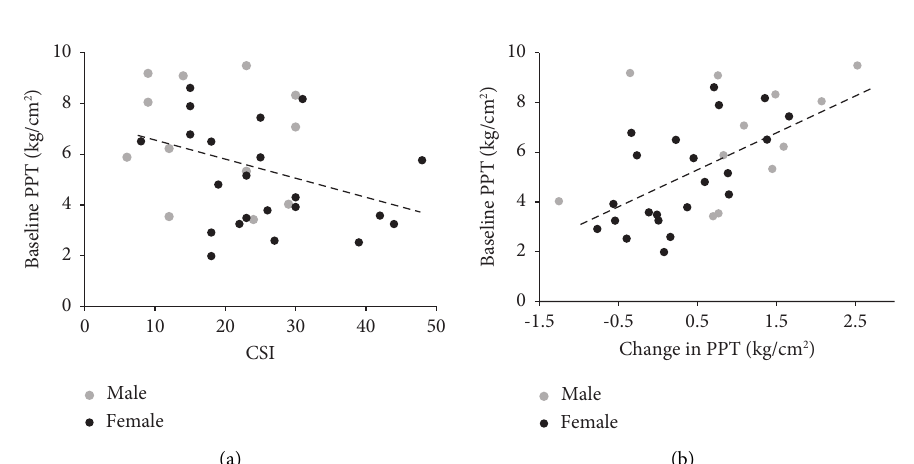
Figure 3: (a) Signifcant linear relationship between baseline pressure-pain threshold (averaged across sites, PPT) and score on the Central Sensitization Inventory (CSI); r � − 0.352; p � 0 . 041. (b) Signifcant linear relationship between baseline pressure-pain threshold (average across sites, PPT) and change in PPT postfatigue; r � 0.576; p � 0 .